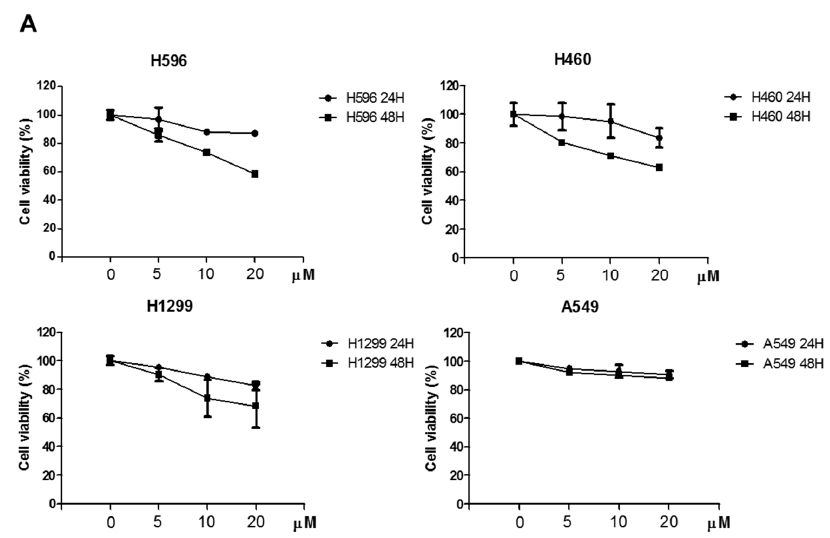
Figure 1. Cont Figure 1. Cont.